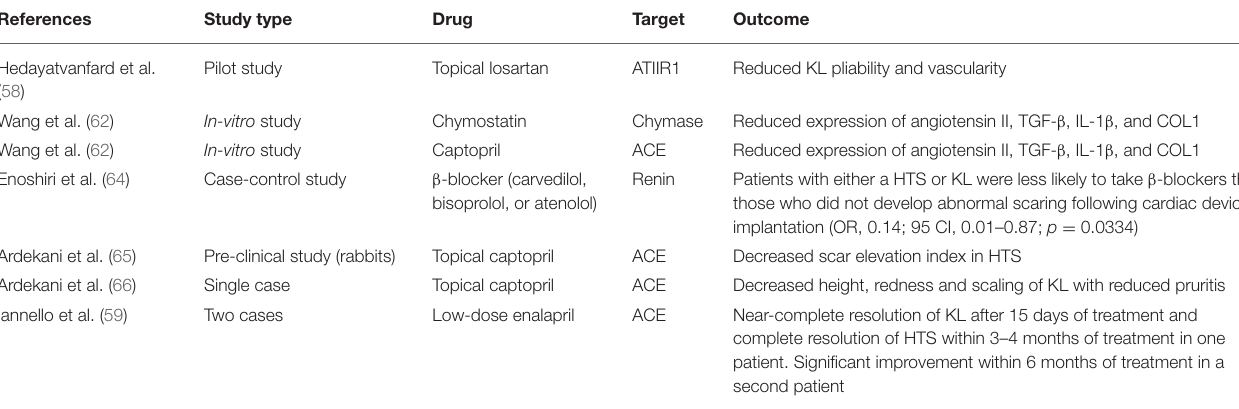
TABLE 1 | Studies on the effect of renin-angiotensin system modulating agents on keloid lesions and hypertrophic